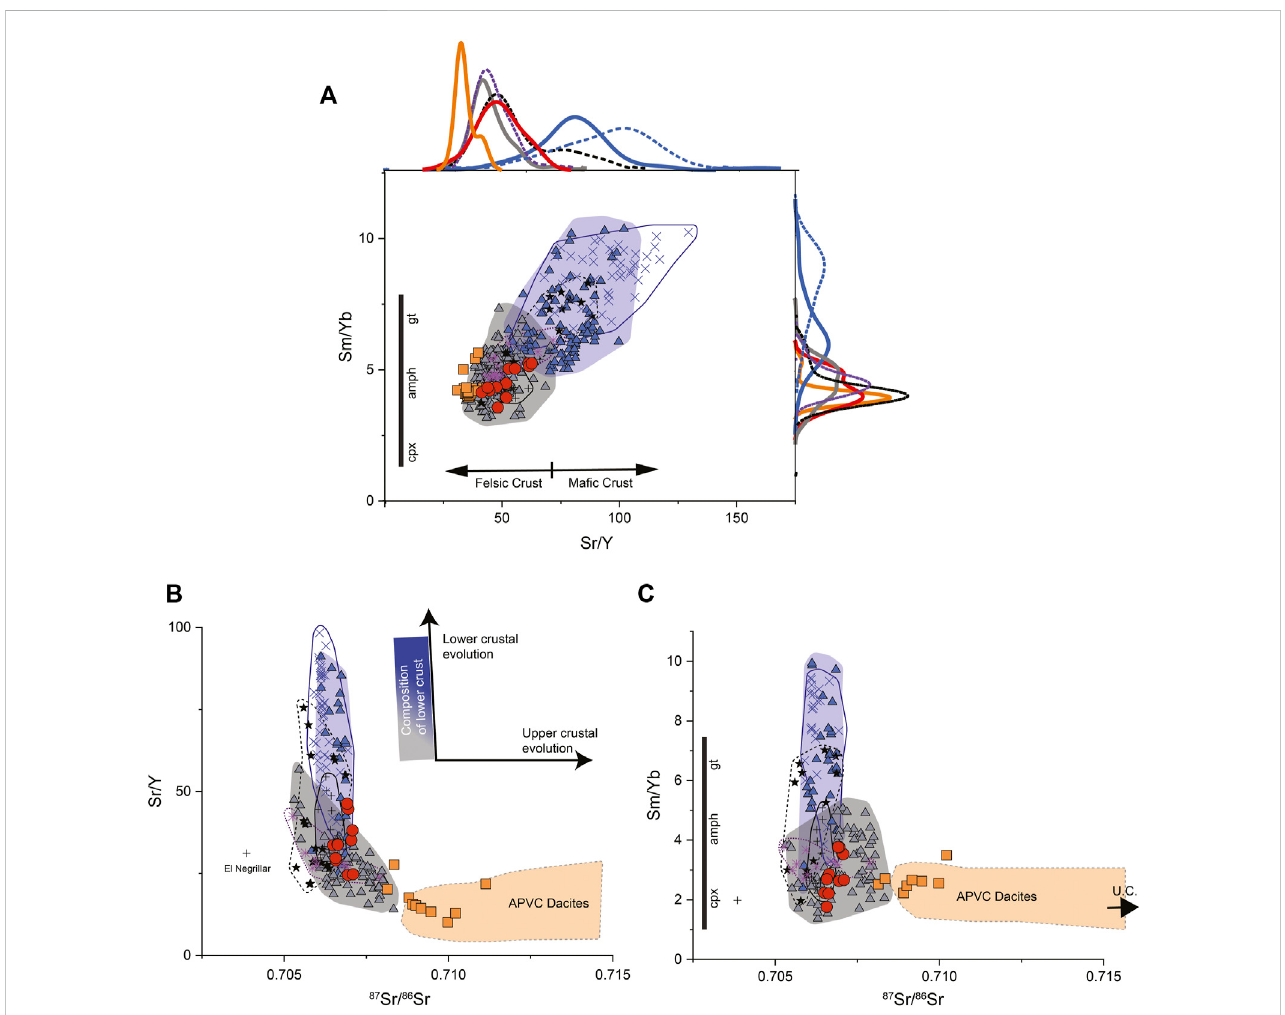
FIGURE 3 (A) PlotshowingSr/Yvs.Sm/Yb.Kerneldensityestimates(KDEs)foreachtraceelementratioandgrouparepresentedonthetopandrightsideoftheplot. KDE bandwidths were calculated using the Silverman method. Arrows show expected Sr/Y ratios in ma fi c vs. felsic lower crust. The vertical line shows the pressure-dependent relationship between Sm/Yb ratios and pyroxene, amphibole, and garnet after Kay and Mpodozis (2001). (B, C) Diagrams show 87 Sr/ 86 Sr vs. the trace element ratios in panel (A) . Both panels include an orange fi eld showing the compositions of fl are-up related dacite ignimbrites from the APVC. Arrows in Figure 3B show the mineralogically and compositionally dependent evolutionary pathways of lower vs. upper crustal magmas. The vertical bar in Figure 3C is discussed in the